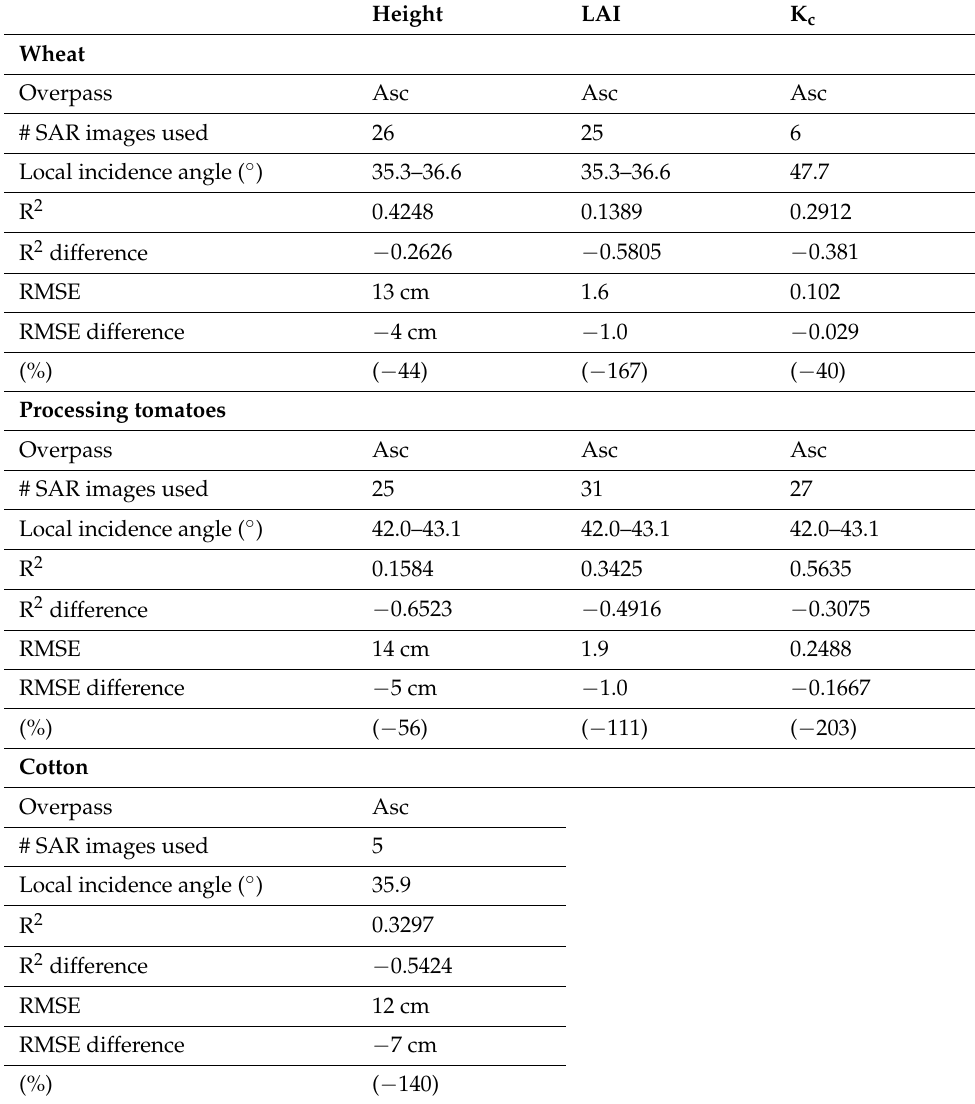
Table 4. RVI models for wheat, processing tomato, and cotton height, LAI, and K c . The differences in R 2 and RMSE indicate the difference in performance compared to models based on either the σ 0 (wheat and cotton models) or β 0 (processing tomatoes) local incidence angle normalization methods in Table 3. Negative values represent lower R 2 and higher RMSE of the RVI